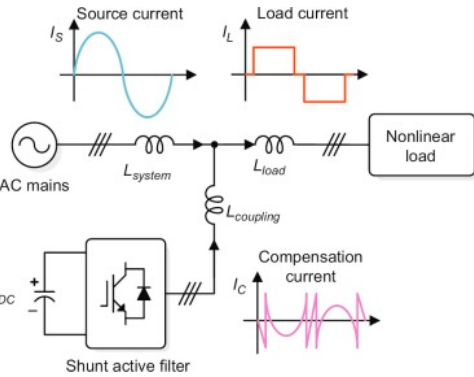
Figure 2. The resulting compensation characteristics due to a shunt active power filter used for com ‐ pensation.